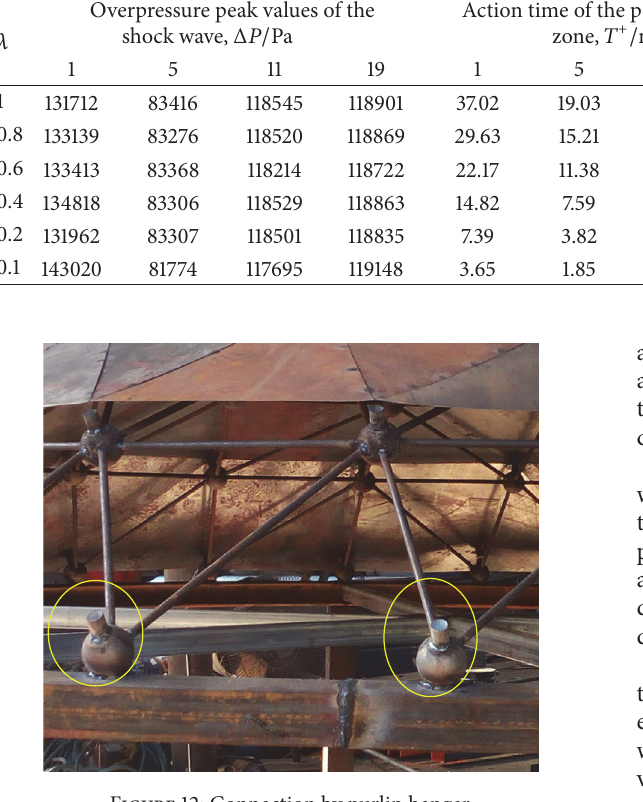
Figure 12: Connection by purlin hanger.